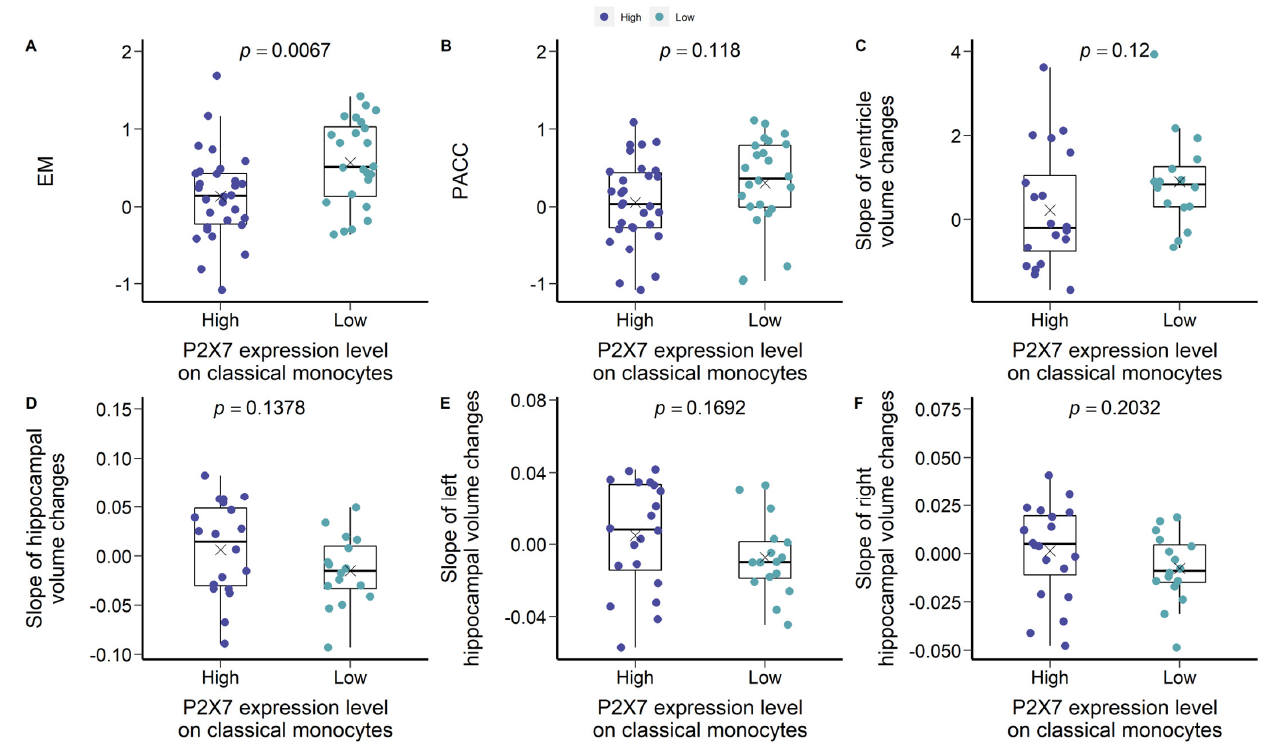
Figure 6. Characteristics of P2X7-low CN −ve and P2X7-high CN −ve groups in the validation cohort A. ( A ) EM. ( B ) PACC. ( C ) Slope of ventricle volume changes per year. ( D ) Slope of hippocampal volume changes per year. ( E ) Slope of left hippocampal volume changes per year. ( F ) Slope of right hippocampal volume changes per year. Two group comparison was determined by t